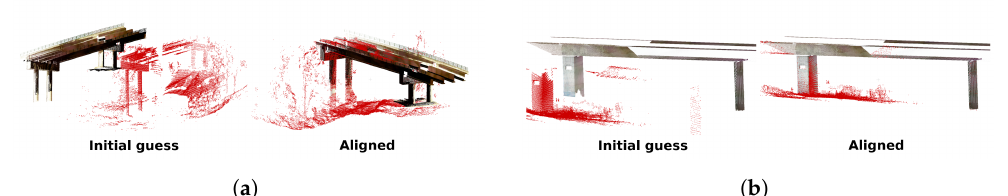
Figure 11. Global localization examples at take-off. Red points are the LIDAR reading. ( a ) Algo- donales, ( b ) Álora. Table 1. Algodonales global localization metrics.